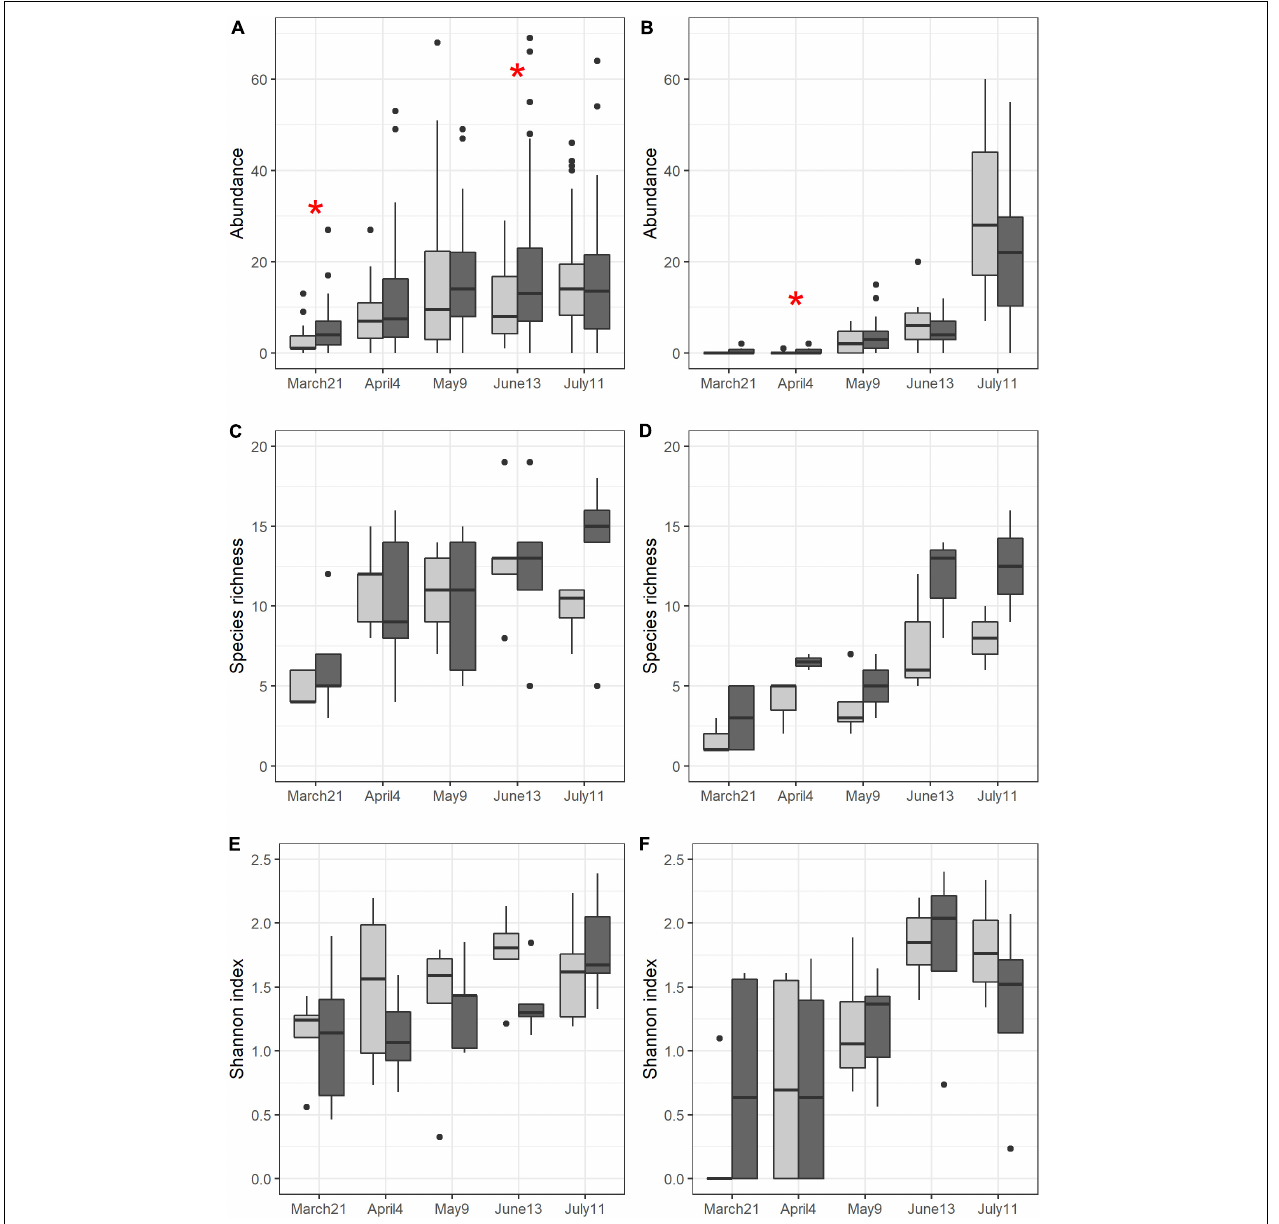
FIGURE 3 | Variations of Abundance per trap (A,B) , species richness per field (C,D) and Shannon index per field (E,F) for circulating (A,C,E) and emerging (B,D,F) carabid communities over time and according to soil management (light gray: conventional, dark gray: conservation). Red asterisk reflects significant difference between soil managements at a specific sampling session. To improve the readability of the figure, 2 outliers were ignored in panel (A) (1 in May in conservation and 1 in June in conservation), 1 outlier was ignored in panel (B) (in July in conservation) and 1 outlier was ignored in panel (C) (in July in